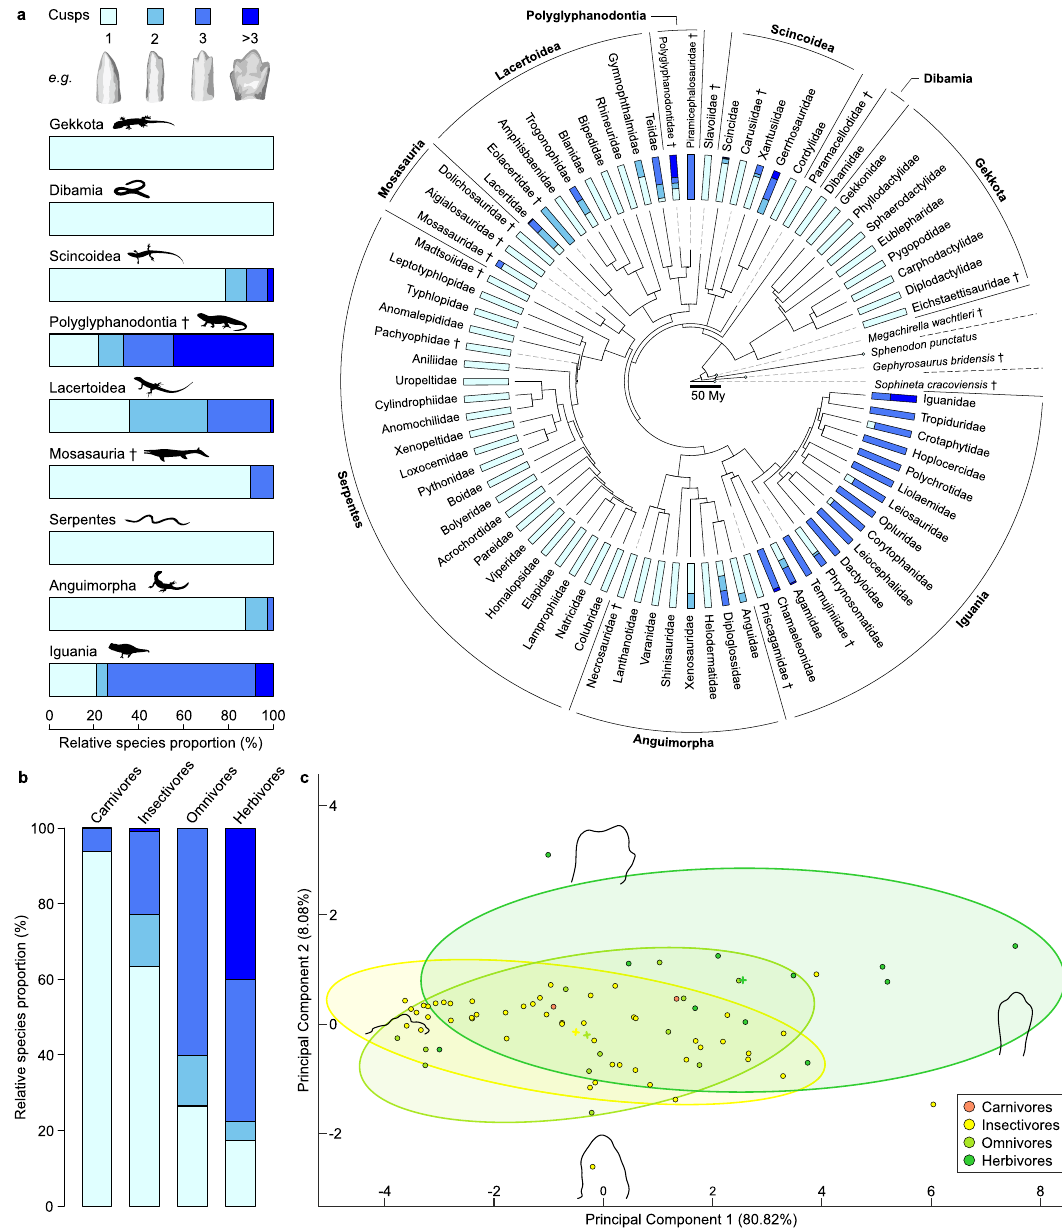
Fig. 1 The diversity of squamate dental morphologies correlates with a gradient of plant consumption. a Relative proportions (%) of tooth complexity levels in all known squamate suborders/super-families (left) and 76 families (right) based on cusp number data for 545 living and extinct species (including the most ancient known squamate Megachirella wachtleri ), two rhynchocephalians, and the stem lepidosaurian Sophineta cracoviensis , with example teeth for each complexity level redrawn from microCT-scan data (not to scale). b Relative proportions (%) of tooth complexity levels in 545 squamates sorted by diet. c Discrete cosine transform analysis of multicuspid tooth labial view pro fi les from 75 extant and fossil squamate species, with 95% con fi dence ellipses for insectivorous, omnivorous, and herbivorous morphologies. Theoretical tooth pro fi les at the extreme positive and negative values of each axis reconstructed from the fi rst 21 harmonic coef fi cients. Scalebar = 50 million years (My). Dagger = extinct taxon. Silhouettes: Phylopic (http://phylopic.org) courtesy of T. Michael Keesey (used without modi fi cation, CC0 1.0 and CC-BY 3.0 https://creativecommons.org/licenses/by/3.0/), David Orr (CC0 1.0), Iain Reid (used without modi fi cation, CC-BY 3.0 https://creativecommons.org/licenses/by/3.0/), Alex Slavenko (CC0 1.0), and Steven Traver (CC0 1.0), and F.L. after Darren Naish (used with permission) and Ted M. Townsend (silhouette drawn from photograph, CC-BY 2.5 https:// creativecommons.org/licenses/by/2.5/deed.en); see Methods for full license information. Source data are provided as a Source Data fi